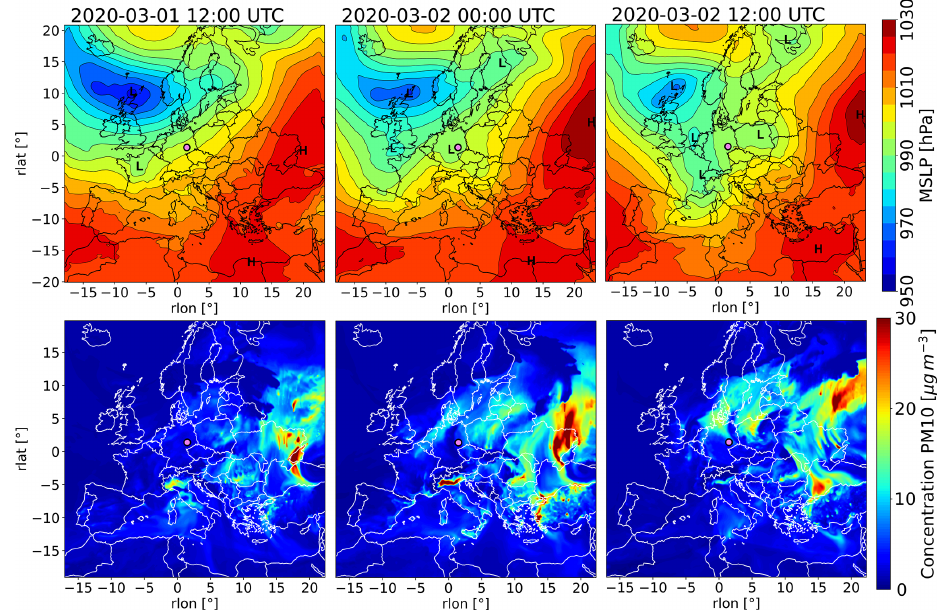
Figure 1. Overview of the synoptic-scale transport and air-quality patterns over Europe during the simulation period in terms of maps of mean-sea level pressure (a–c) and modeled near-surface PM 10 concentrations (d–f) . The magenta dot marks the location of the city of Leipzig in eastern Germany. The maps are in rotated geographic coordinates, where the coordinates of the rotated pole are 40 ◦ N, − 170 ◦ E (see Sect. 2.3 for a detailed description of the model setups). Table 1. Overview of the air-monitoring sites used for model evaluation. For the pollutants, only the relevant species to our model evaluation are denoted. Note also, that the station LC is both a public and scientific site. Location Lützner Str. Richard Wagner Str. Schönauer Str.